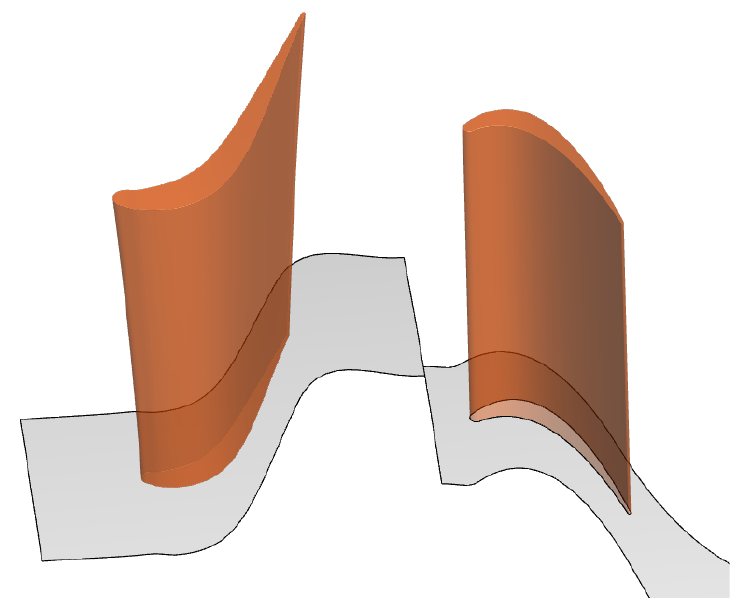
Figure 1. A typical low-pressure vgt from a marine gas turbine.